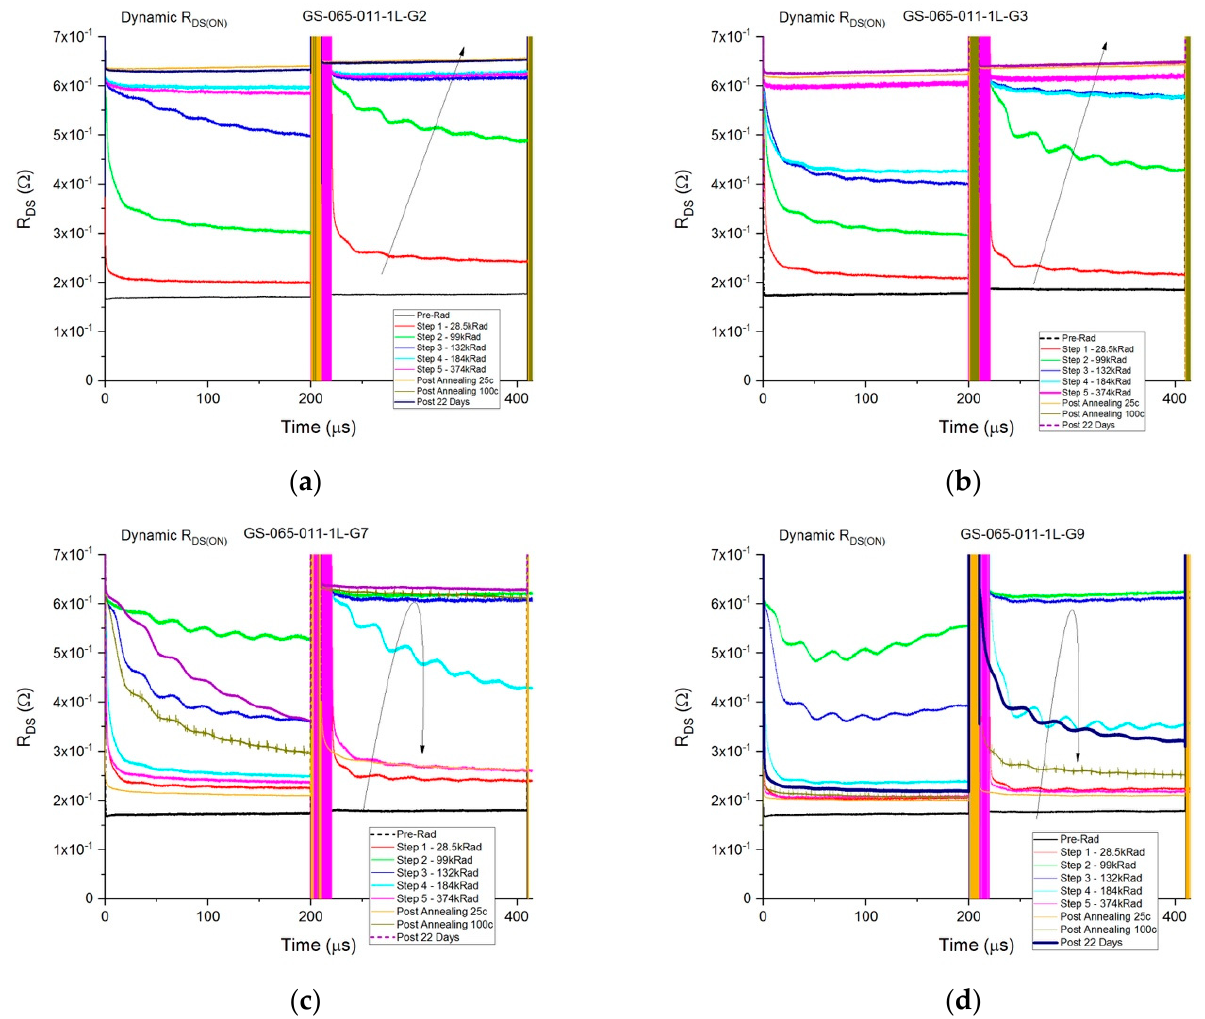
Figure 9. The dynamic R ON double pulse measurements in the off state (V DS = 500 V and V GS = − 5 V) and on state (V GS = 3 V and I DS = 2.5 A): ( a ) device G2, which was subjected to drain and gate voltage stress during irradiation at 133 °C; ( b ) device G3, which was subjected to drain voltage stress during irradiation at 133 °C; ( c ) device G7, which was subjected to drain and gate voltage stress during irradiation at 53 °C; ( d ) device G9, which was subjected to drain voltage stress during irradiation at 53 °C.